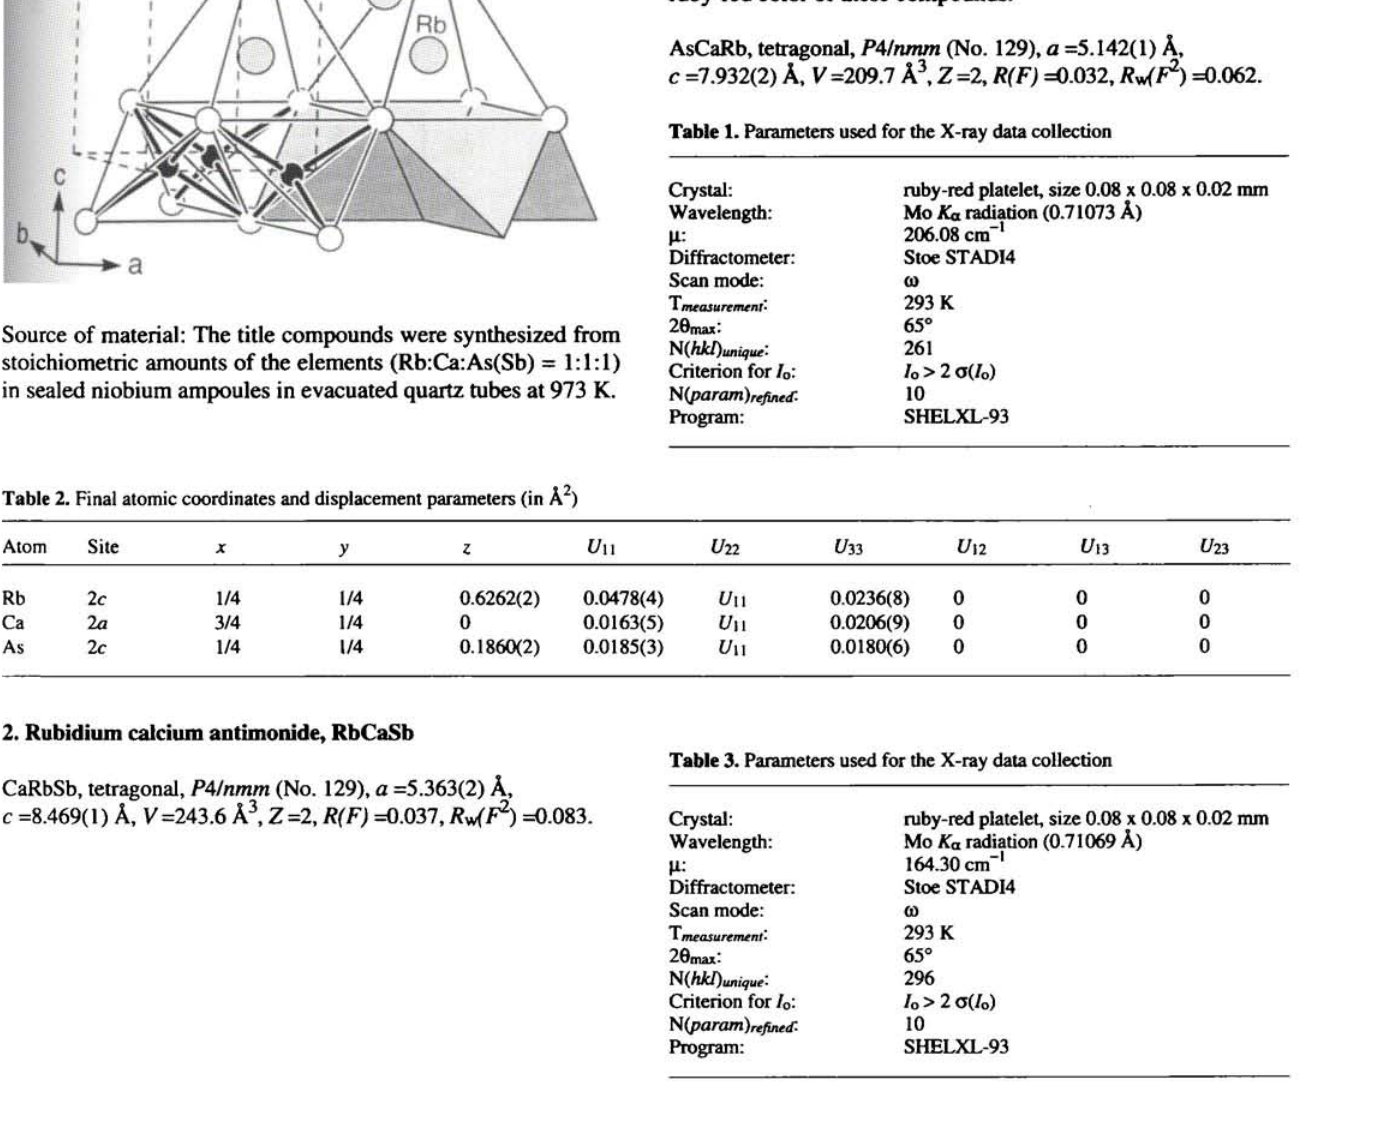
Table 3. Parameters used for the X-ray data collection